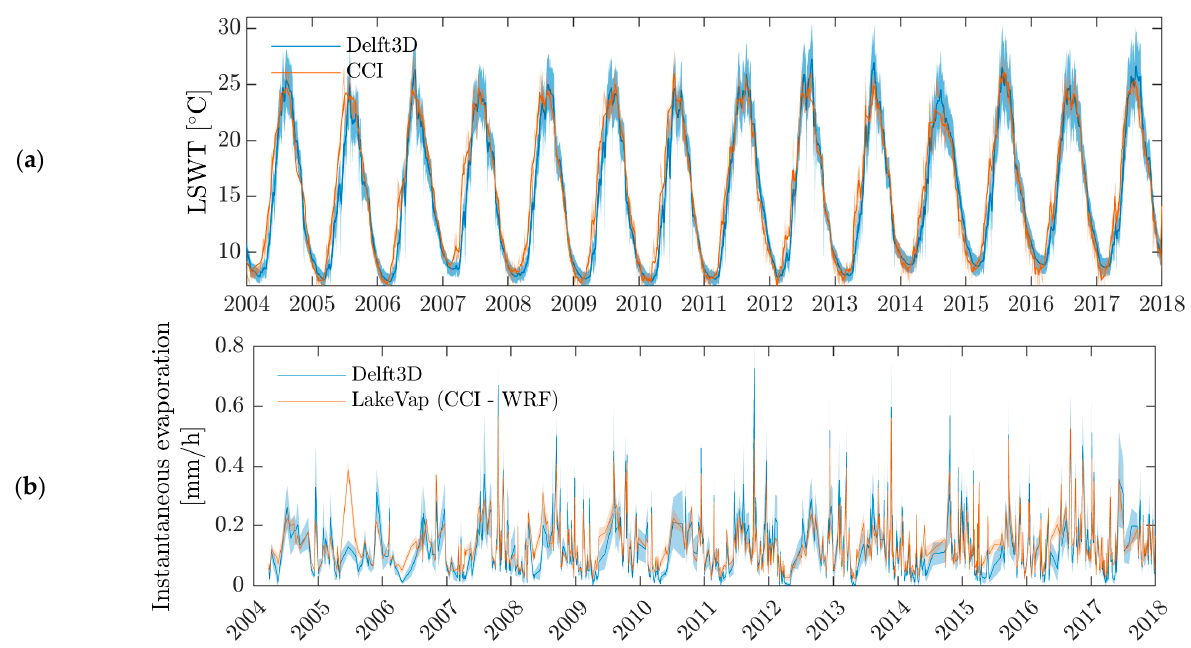
Figure 5. ( a ) Comparison between instantaneous evaporation ( E h ) from Lake Garda, estimated with LakeVap using CCI-Lakes dataset and WRF spatially averaged meteorological data, and hourly evaporation simulated by Delft3D hydrodynamic model. ( b ) Comparison between LSWT derived from CCI-Lakes dataset and simulated by Delft3D hydrodynamic model. Shaded areas represent the standard deviation from the spatial mean (continuous line). To ease the comparison, the results from Delft3D are plotted on the days when LakeVap products are available (blue line), while the std (light blue shadow) is provided for all simulated days. Table 3. Performance of LakeVap tool based on CCI-Lakes LSWT and WRF, MET1, MET2, and ERA5 meteorological data. Metrics are computed for instantaneous evaporation estimates ( E h ) and for CCI-Lakes LSWT maps. Metrics assume Delft3D model results as the “true” value. * statistics computed on a shorter time series (2012–2018) due to the reduced availability of MET2 data.